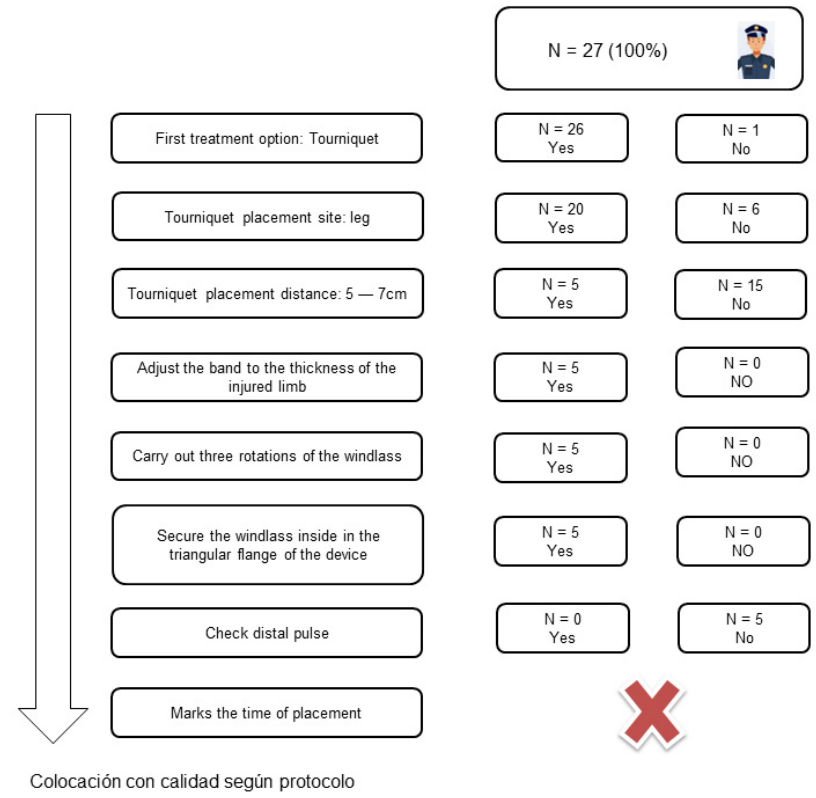
Figure 2. Proper placement flow chart in accordance with the protocol.